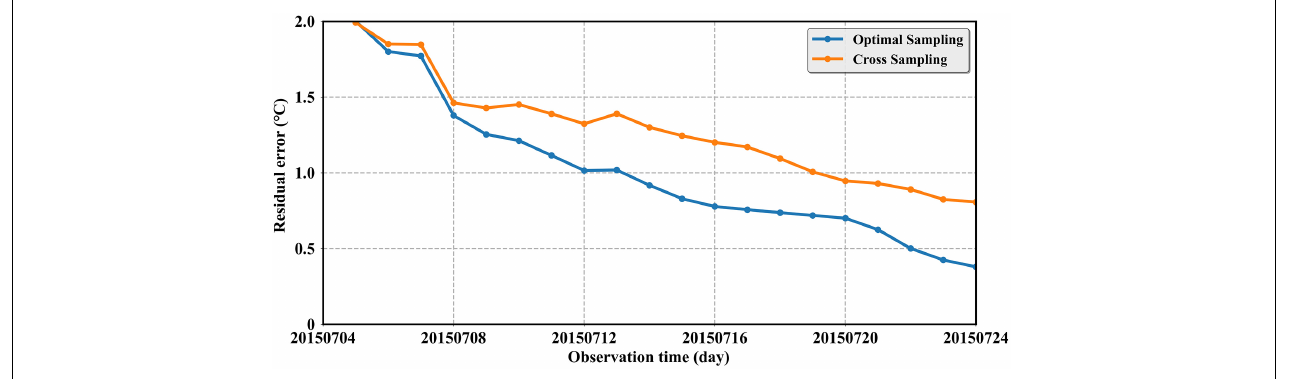
FIGURE 12 | The curves of the average residual errors within the target eddy of two methods varying with the observation time from July 5 to July 24, 2015.